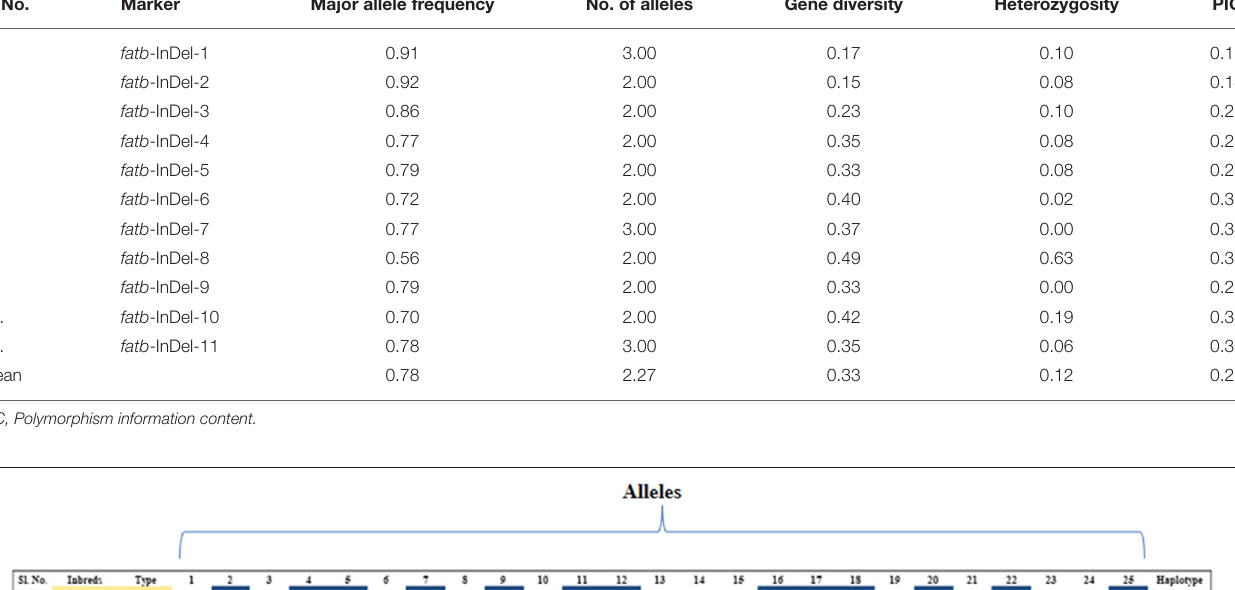
To strengthen the clustering pattern of maize and the orthologues, the protein sequences were predicted and evolutionary tree was generated using the protein sequences. Clustering revealed the same pattern as that of